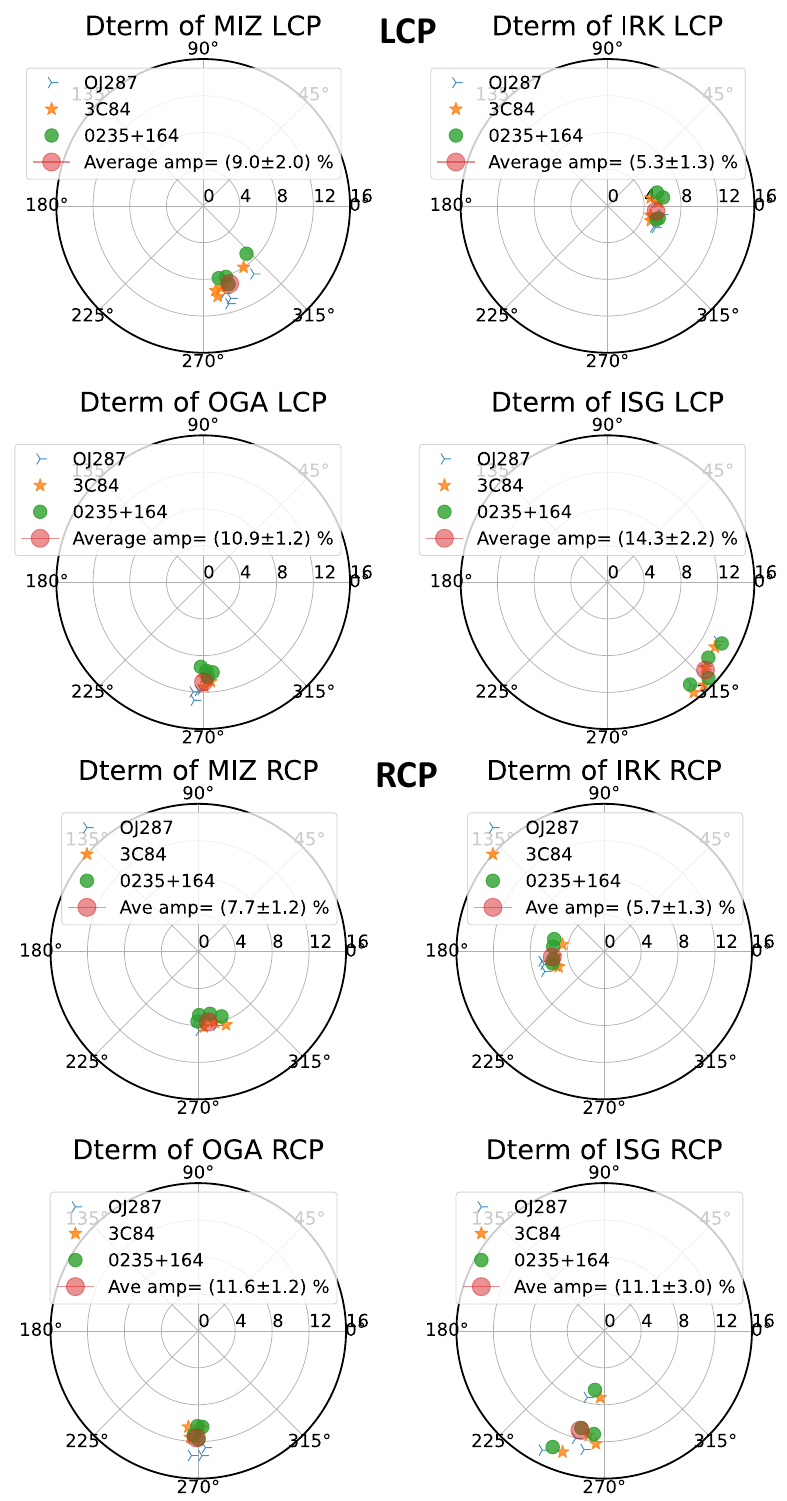
Figure 6. D-terms obtained at 43 GHz. Description of what is contained in the Figure 5